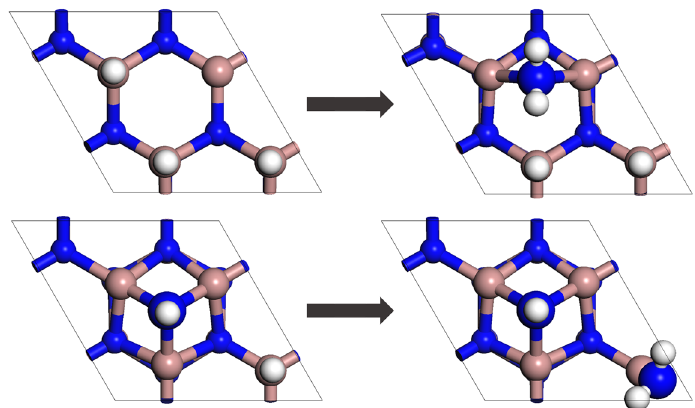
Figure 1. Surface structures before and after the chemical adsorption reactions: (upper row) NH 3 (g) + S[3Ga-H] → H 2 (g) + S[NH 2 (br) + 2Ga-H], (lower row) NH 3 (g) + S[N ad -H + Ga-H] → H 2 (g) + S[N ad -H + Ga-NH 2 ]. Brown, blue, and white atoms are gallium, nitrogen, and hydrogen, respectively.